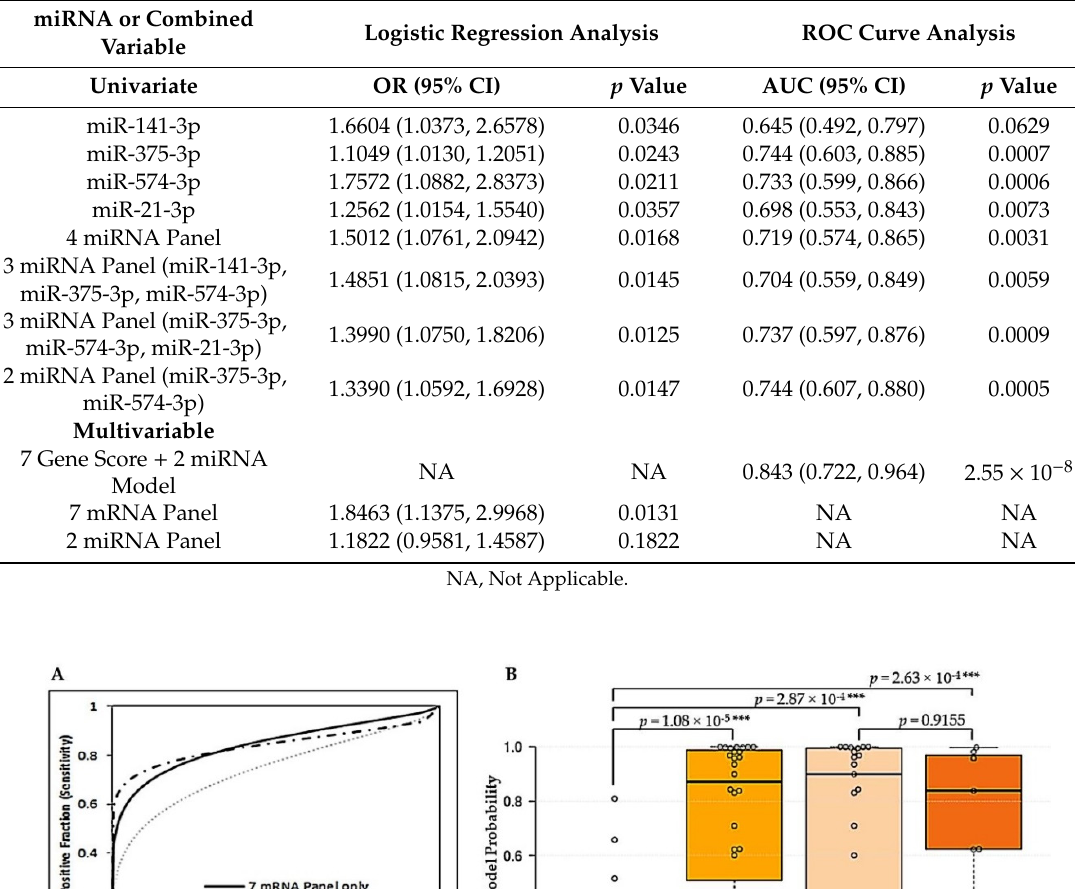
Table 4. Performance of urinary Vn96-isolated EV miRNA biomarkers and combined mRNA + miRNA model for prostate cancer prediction and diagnosis.